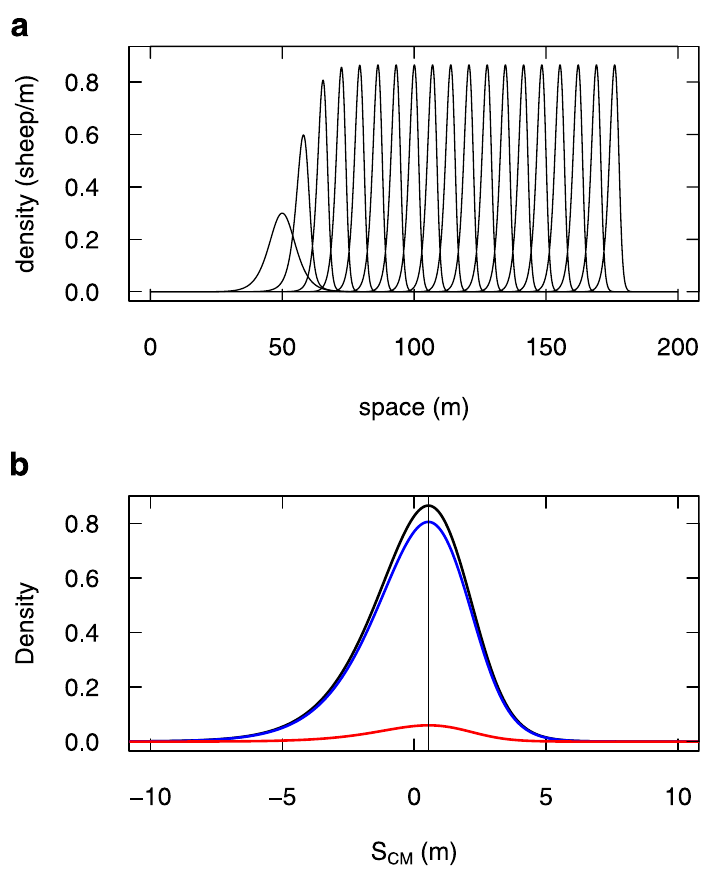
Fig 5. Density Model prediction for 1D-propagation. (a) The predicted evolution of a group of 4 sheep is the formation of a traveling pulse, which travels at constant speed, and with no dispersion (the leftmost profile is the initial condition, the rightmost profile is at time 1800 s, intermediate profiles are every 100 s; numerical solution of Eqs 5 and 6, with Δ t = 10 − 2 s). (b) The stabilised profile (black line, at time 1800 s) is zoomed out to show the density distribution around the group center of mass (0 abscissa). It displays a slight asymmetry (vertical line through the distribution peak for visual guidance), with an excess of density in the left tail (at the rear of the group). The underlying densities of stopped (blue) and moving (red) appear homogeneously proportional to the